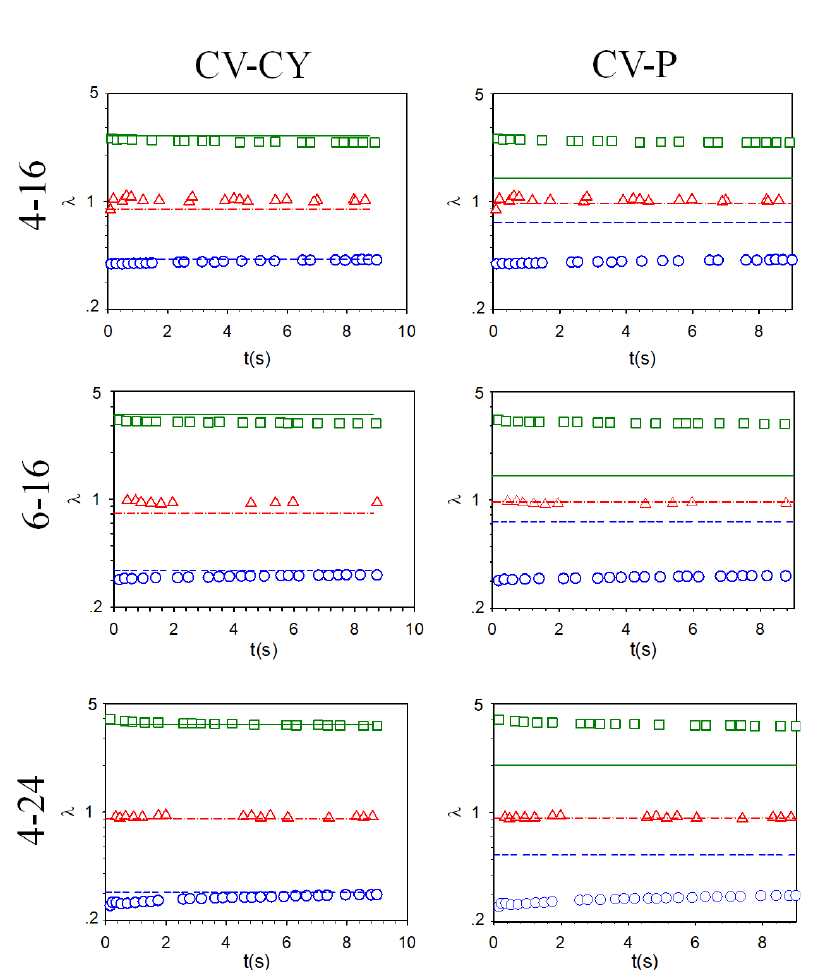
Figure 6: Normalized droplet dimensions as a function of time after step shear experiments (from [22]) carried out at different shear rates (row 1: strain = 4 and shear rate = 16 s −1 - denoted in the figure as 4-16, row 2: strain = 6 and shear rate = 16 s −1 - denoted as 6-16, and row 3: strain = 4 and shear rate = 24 s −1 - denoted as 4-24), compared to the CV-CY model (first column) and the CV-P model (second column). Squares, triangles and circles are experimental normalized droplet lengths, widths and thicknesses, respectively. Solid lines, dash-dotted lines and dashed lines are theoretical predictions using the CV model for normalized droplet lengths, widths and thicknesses,